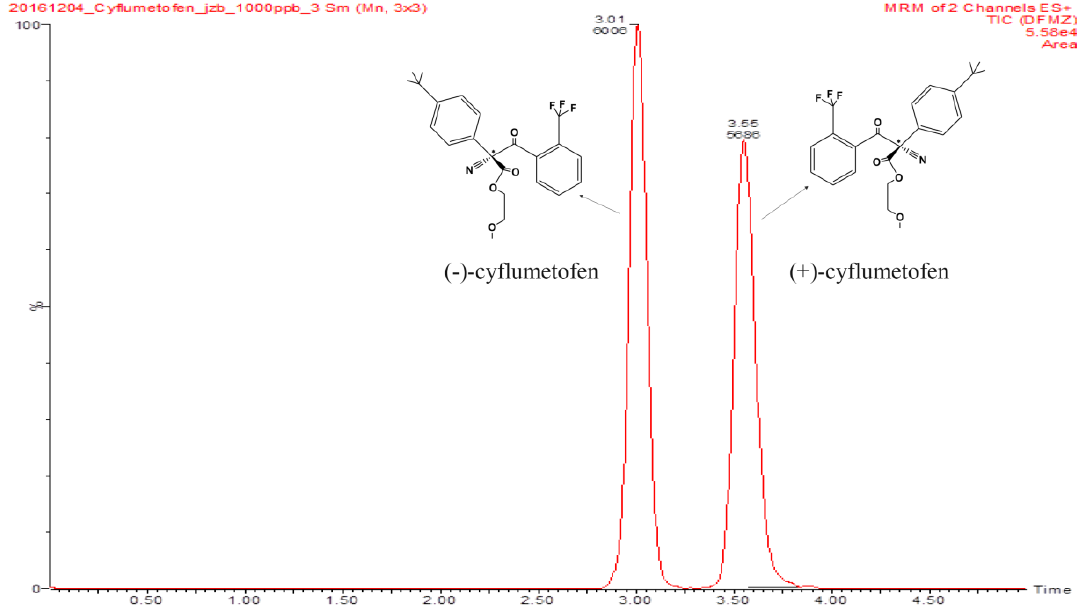
Figure 1. UPCC-MS/MS chromatograms of cyflumetofen enantiomers.